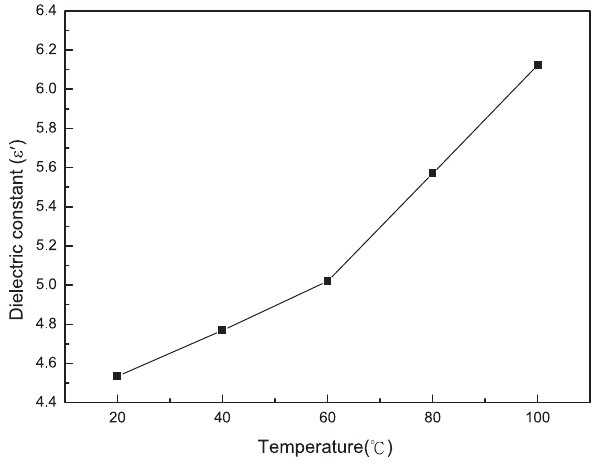
Fig. 7: Variation of dielectric constant of sodium chloride (4% moisture content) with temperature at 2.45